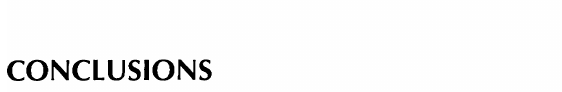
FIGURE6(a) Time response ofy of the uncontrolled prism, y(O) = 0.5, U = 2.